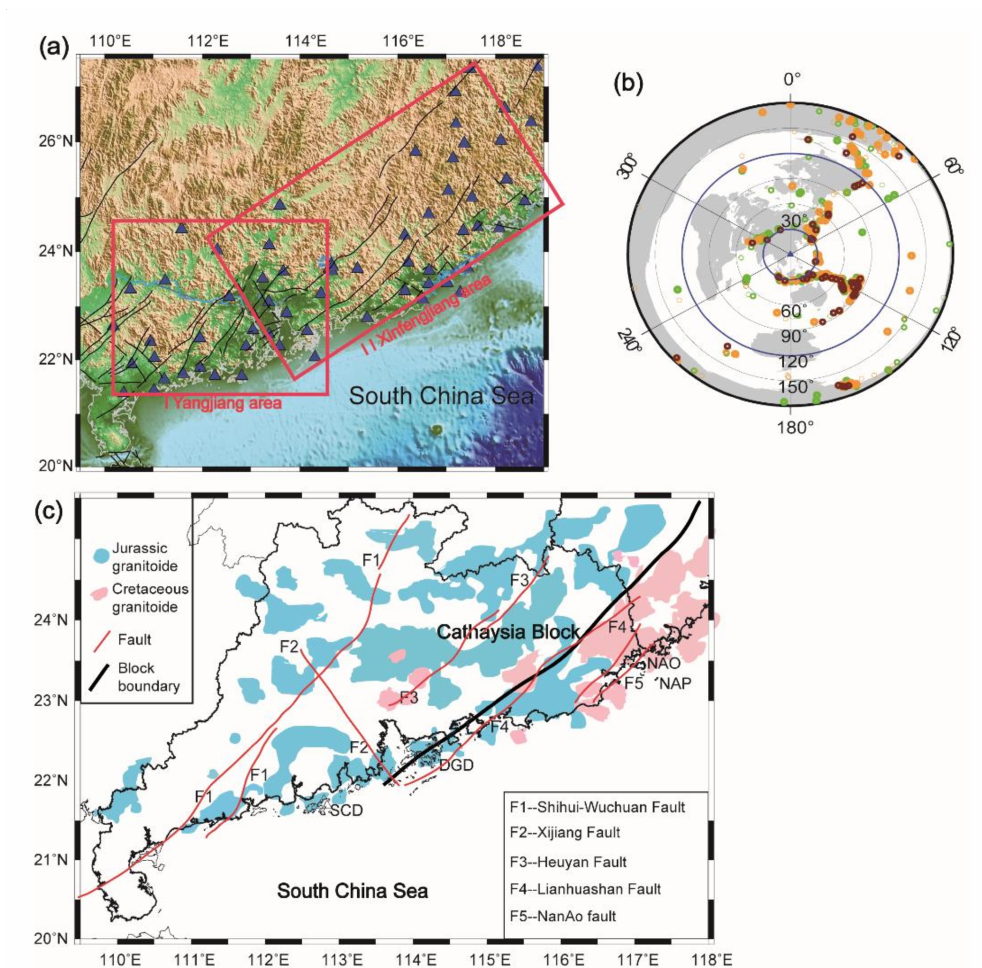
Figure 1. Spatial distributions of seismic stations ( a ) and seismic events ( b ) in the study area. The seismic events that are used in calculating the receiver function are shown in ( b ). The distribu- tion of Mesozoic granites in ( c ) was retrieved from Li [28], while the late Mesozoic volcanic arcs were retrieved from Zhou et al. [3] and Li et al. [29]. LHSF represents the Lianghuashan fault; SWCF represents the Sihui-Wuchuan fault. XIJF and HEYF represent the Xijiang fault and Heyuan fault,